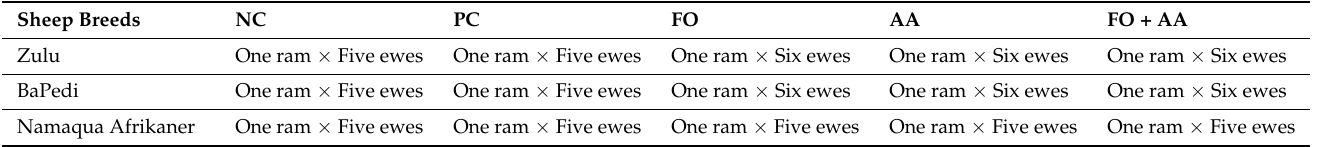
Table 2. Allocation of study animals (rams and ewes) per treatment diets during